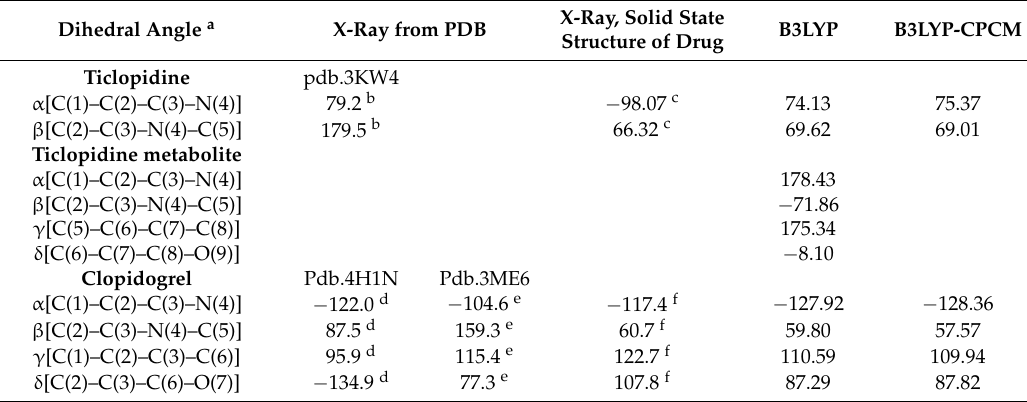
Table 1. Optimized dihedral angles (degrees) of the antiplatelet drugs studied. CPCM, conductor-like polarizable continuum model.